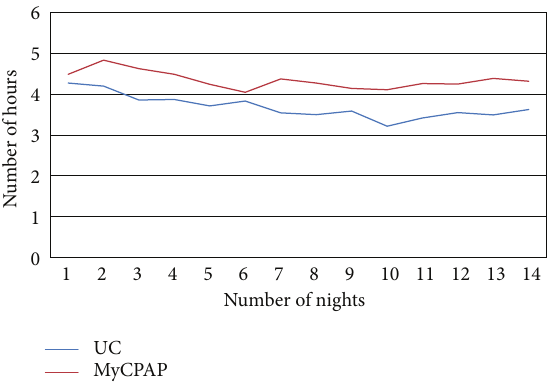
Figure 1: Adherence data over first 14 nights of CPAP usage.